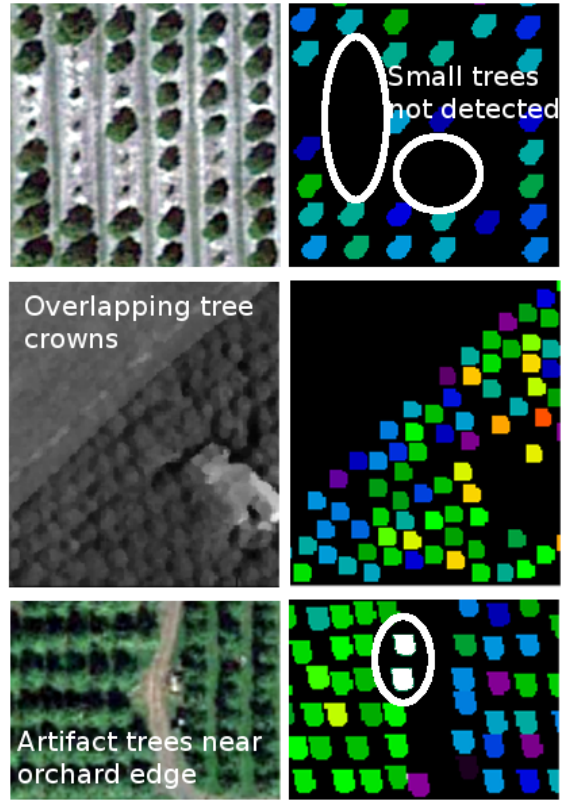
Figure 6: Some of the problem situations encountered by the tree counting